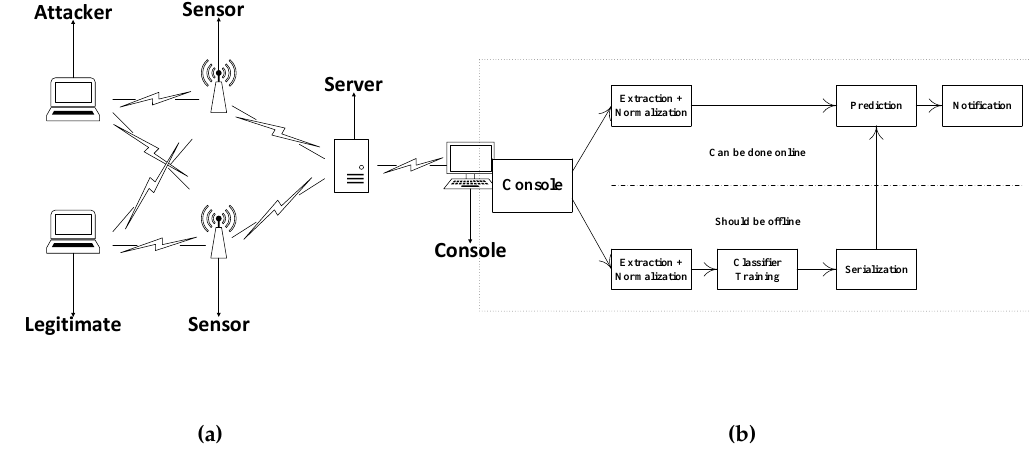
Figure 1. Network architecture and profiling. ( a ) Network architecture; ( b ) profiling and